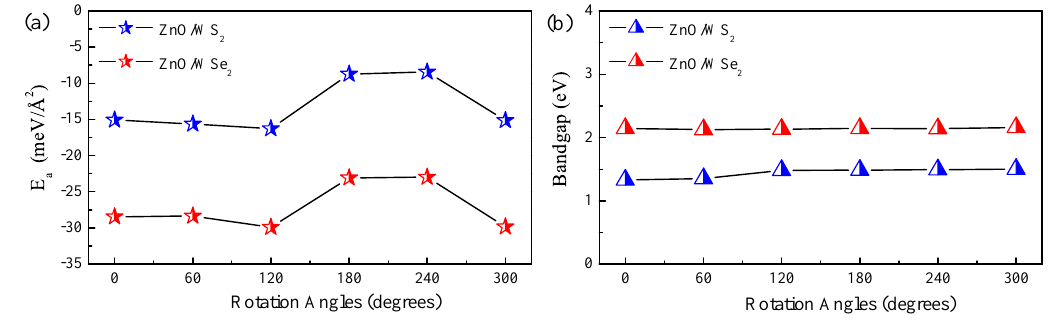
Figure 2. ( a ) Interface adhesion energies and ( b ) bandgaps of ZnO/WS 2 and ZnO/WSe 2 with different rotation angles.